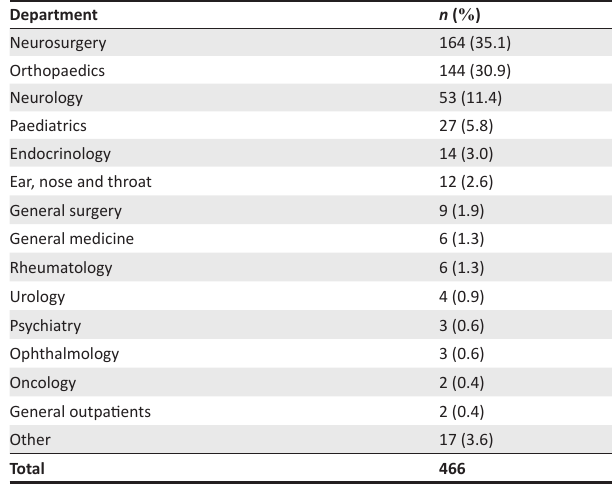
TABLE 1: Referrals by outpatient department.